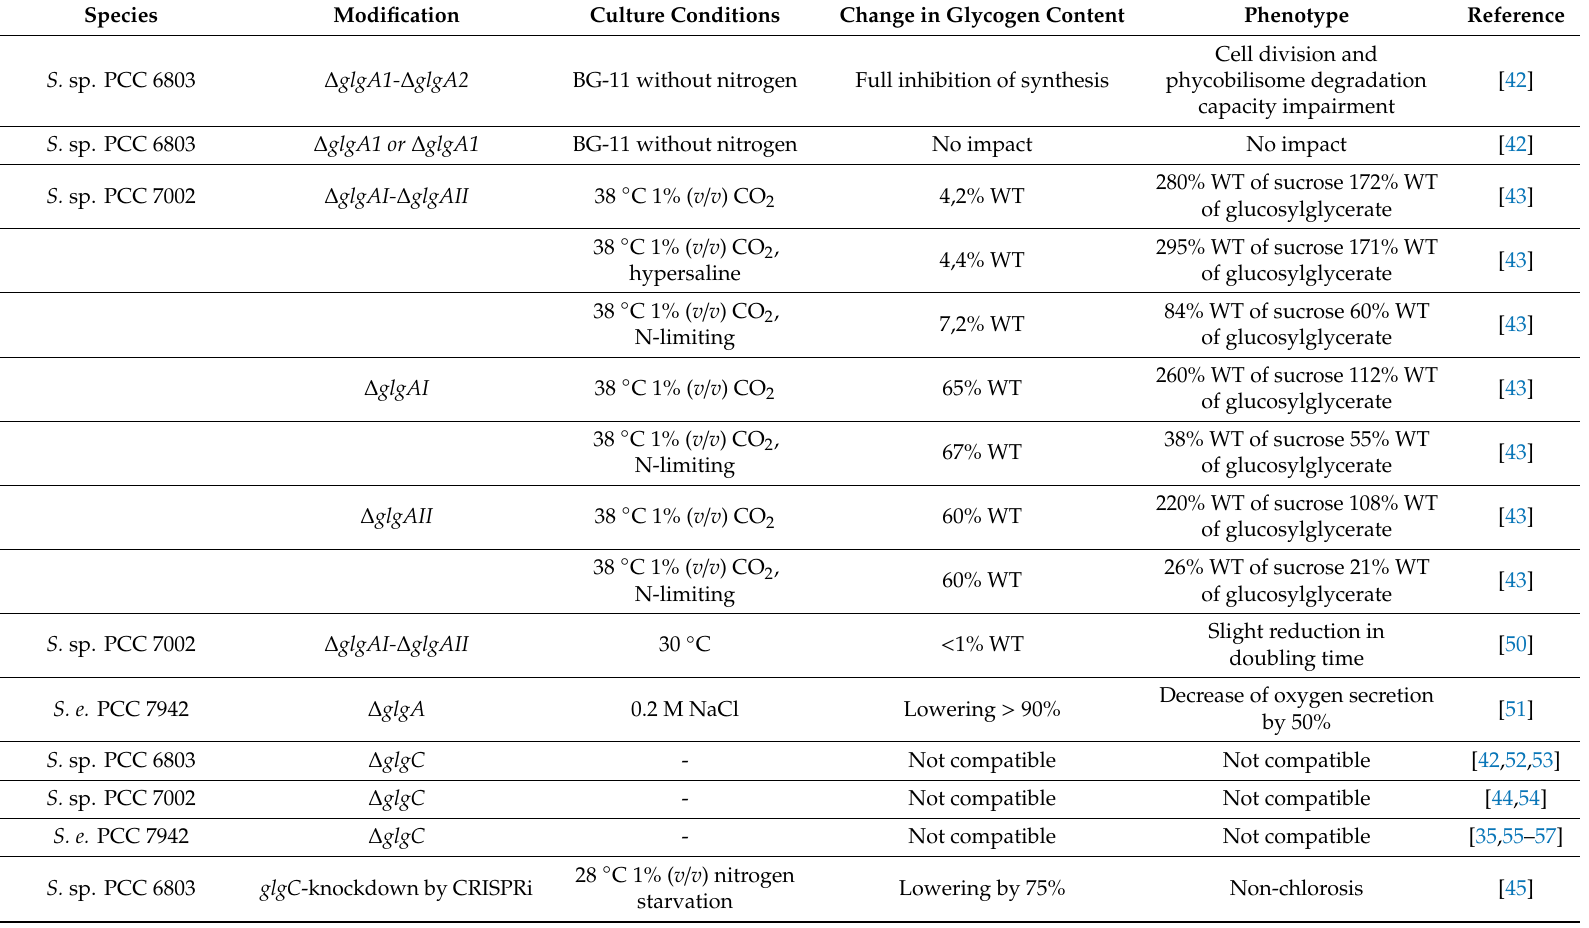
Table 1. Studies on glycogen in genetically modified